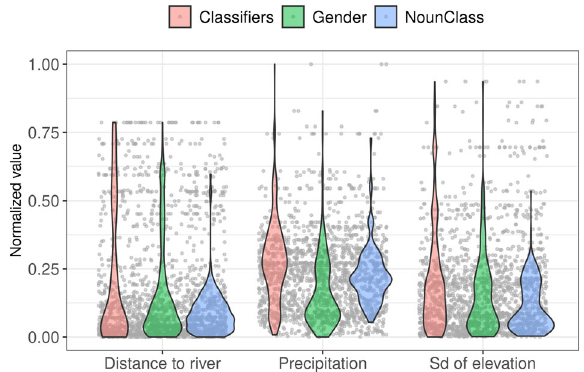
Fig. 3 The values of distance to river, precipitation in the wettest quarter, and the standard deviation of elevation for languages of each nominal classi fi cation system, in which classi fi er languages have the largest variance. The values of the three environmental factors have been normalized to a scale from 0 to